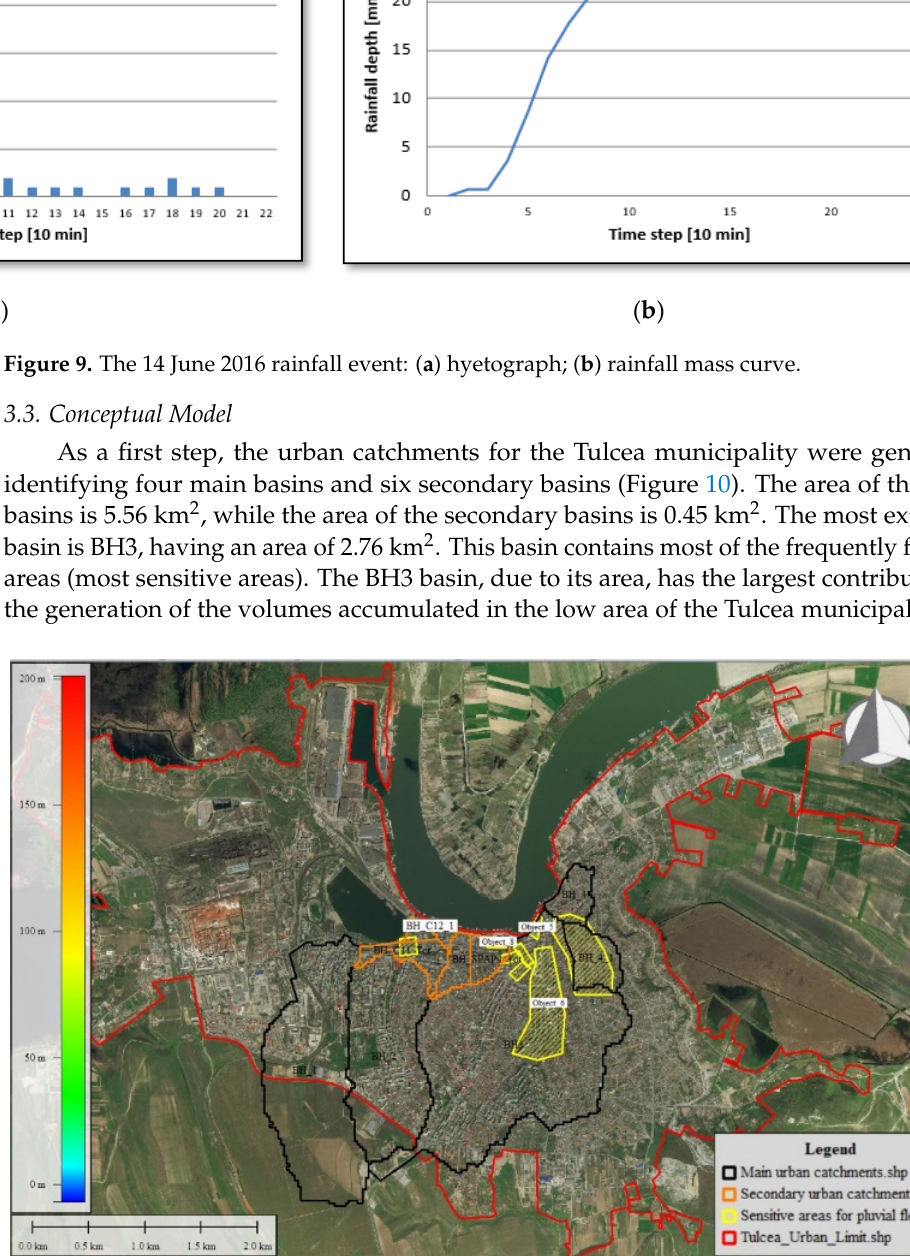
( b ) Figure 8. The 12–13 September 2013 rainfall event: ( a ) hyetograph; ( b ) rainfall mass curve. The maximum rainfall values were recorded around 7:10 a.m. on 13 September 2013 (at the end of event). Precipitation prior to the maximum affects the initial humidity in the study area, leading to the increase of the runoff coefficient. •